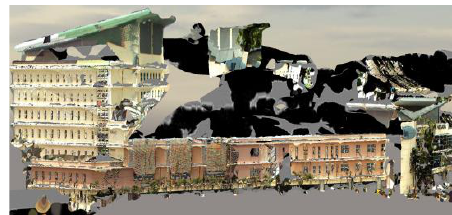
Figure 4: 3D Mesh Model for The National Heart Institute of Malaysia.